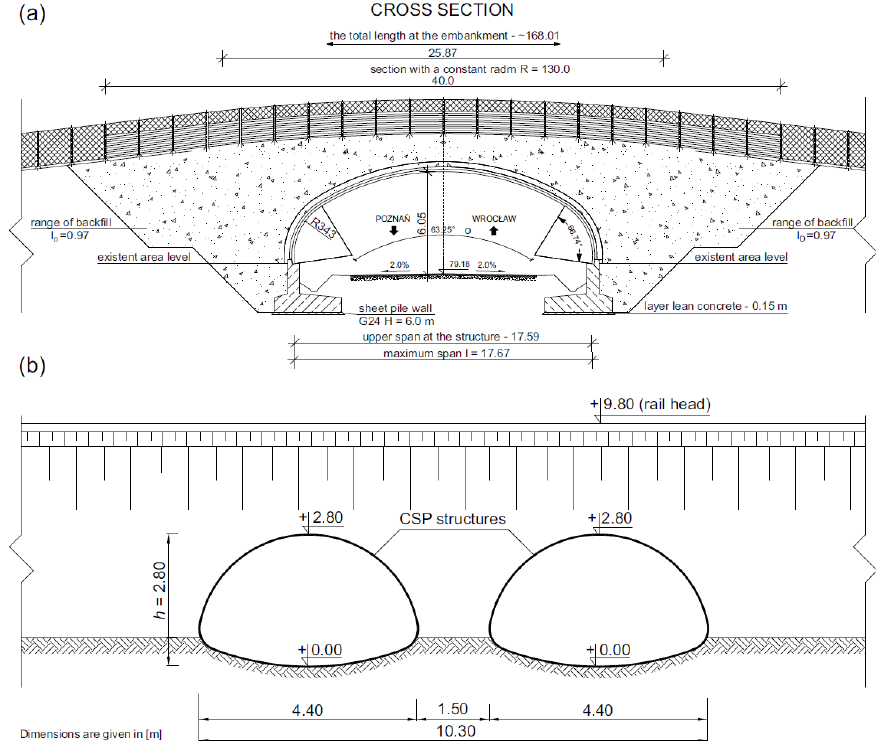
Figure 5. Cross section of: ( a ) bridge #I with single steel shell, ( b ) bridge #II with double steel shell.